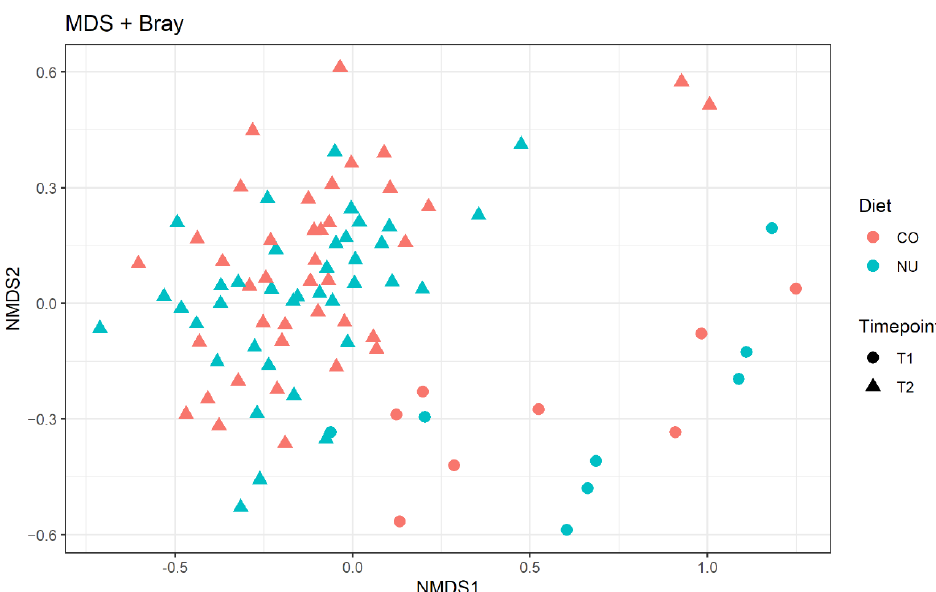
Figure 2. Non-metric multi-dimensional scaling (NMDS) plot on Bray–Curtis distances at ASVs level. CO: control group, NU: nucleotide supplementation. T1: weaning. T2: 12-d post weaning. For the taxonomic composition, at weaning, the phylum Epsilonbacteraeota was sig- nificantly more abundant in the NU group compared with the CO group (log2FC: 2.30, p adj < 0.01); within this phylum, the most represented family in NU was that of Campylo- bacteraceae (log2FC: 3.14, p adj: 0.03), while Streptococcaceae were more abundant in the CO group (log2FC: — 5.36, p adj < 0.01). There were no statistically significant differences